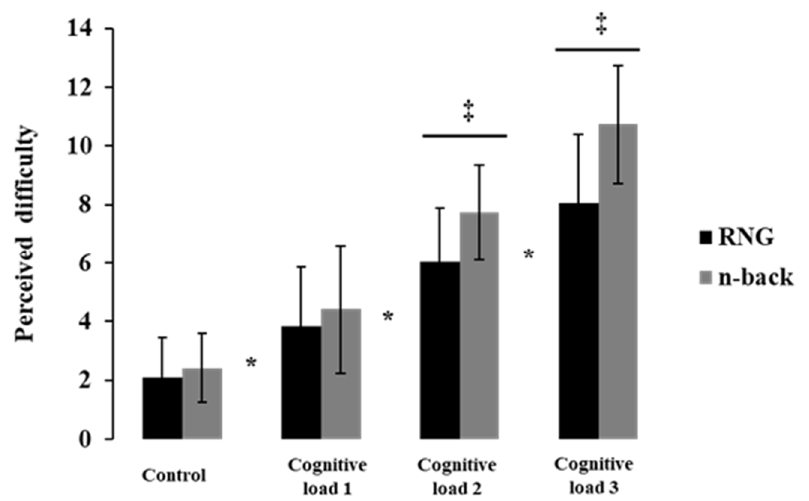
Figure 3. The perceived difficulty as a function of cognitive load and task. * p < 0.05 significant difference between control (CNT or 0-back) and others cognitive load (cognitive load 1: RNG1 or 1-back; cognitive load 2: RNG2 or 2-back; cognitive load3: RNG3 or 3-back); ‡ p < 0.05 significant difference between the tasks (RNG vs. n-back) during cognitive load 2 and cognitive load 3; error bars indicate standard error.